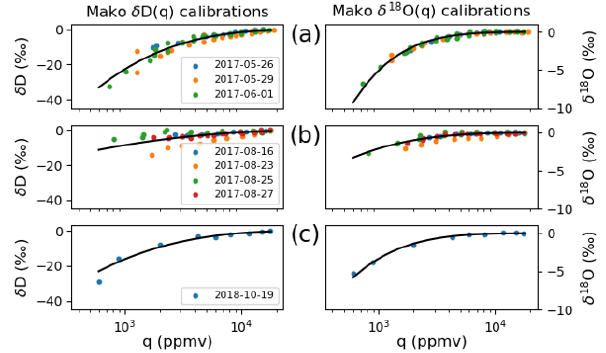
Figure B1. Mako isotope ratio humidity-dependence corrections for ORACLES (a) 2016, (b) 2017, and (c) 2018. Data points are colored by the date that the calibration was performed. Fit curves are generated using nonlinear regression with Eq.